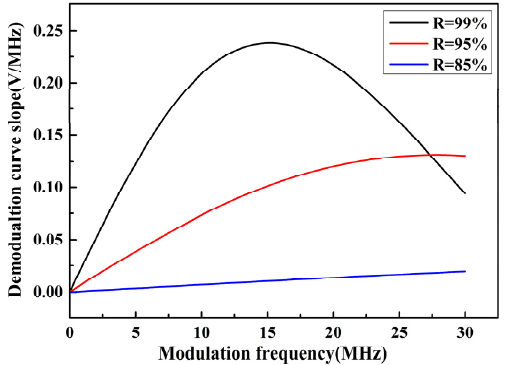
Figure 6. The simulation slope change characteristics of the FOASs under different Q factors.